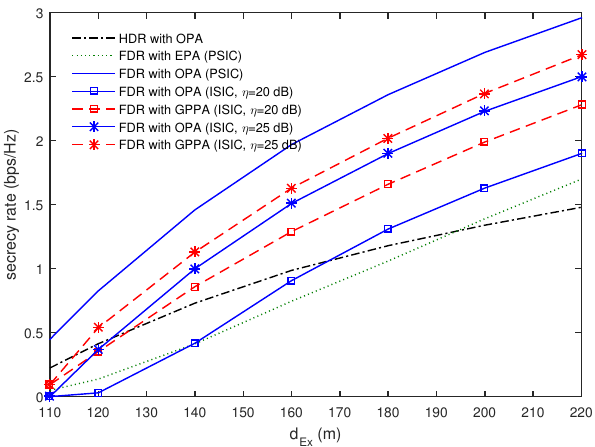
Figure 3. Comparison of secrecy rates as a function of d Ex when T = 4, T E = 2, d E = 10 m, and P = 60